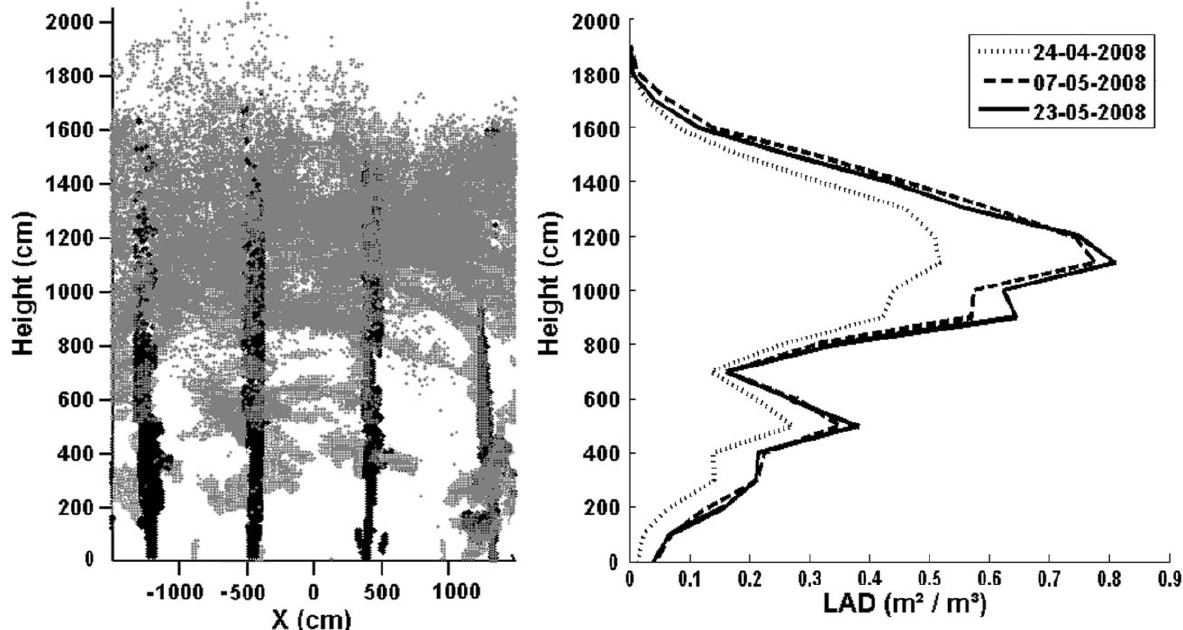
Figure 2. (a) Voxel-based representation of a studied forest plot from 24 April 2008 after preprocessing: ‘leaf’ and ‘stem’ voxels are presented in grey and black, respectively. (b) Vertical Leaf Area Density (LAD) profiles for three different time